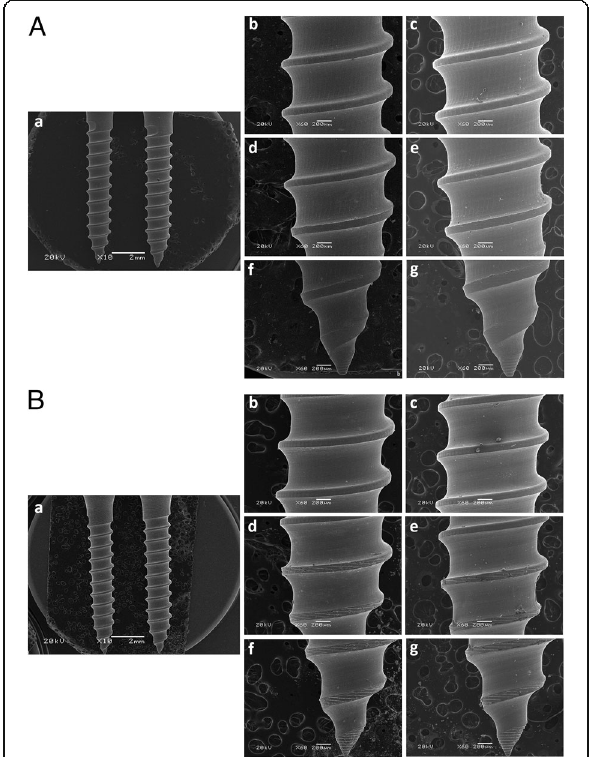
Fig. 4 SEM analysis of the red side of 1.5 mm diameter SS-MI ( a ) and TA-MI ( b ). a × 10 magnification image showing the entire MI thread. b , d , f Pre-insertion evaluation at × 60 magnification of MI threads at H1, H2, and H3. c , e , g Post-insertion evaluation at × 60 magnification of MI threads at H1, H2, and H3